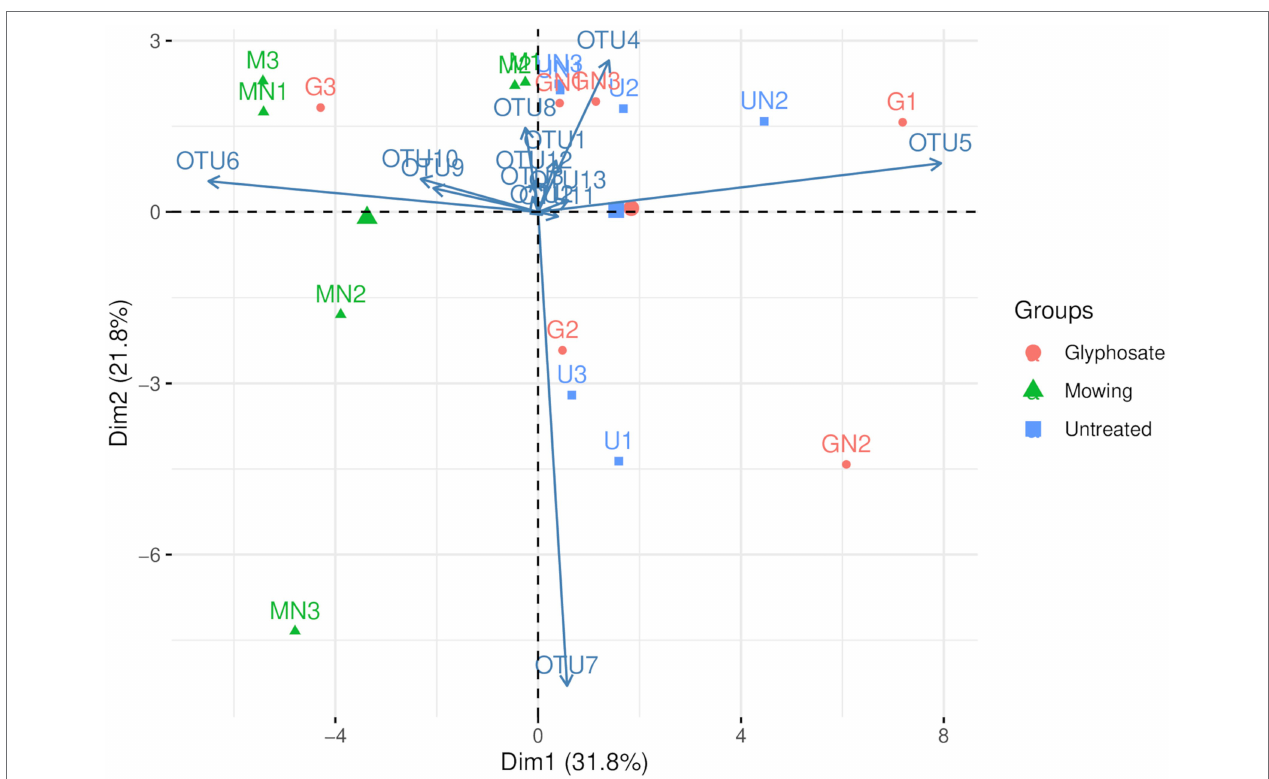
FIGURE 2 | Compositional biplot of AOA communities using centered log-ratio transformed data (Aitchison transformation). The letter M in the labels of samples indicates mowing termination, letter G desiccation with glyphosate and letter U untreated control. Letter N indicates N fertilization and the number identifies the replicate of each